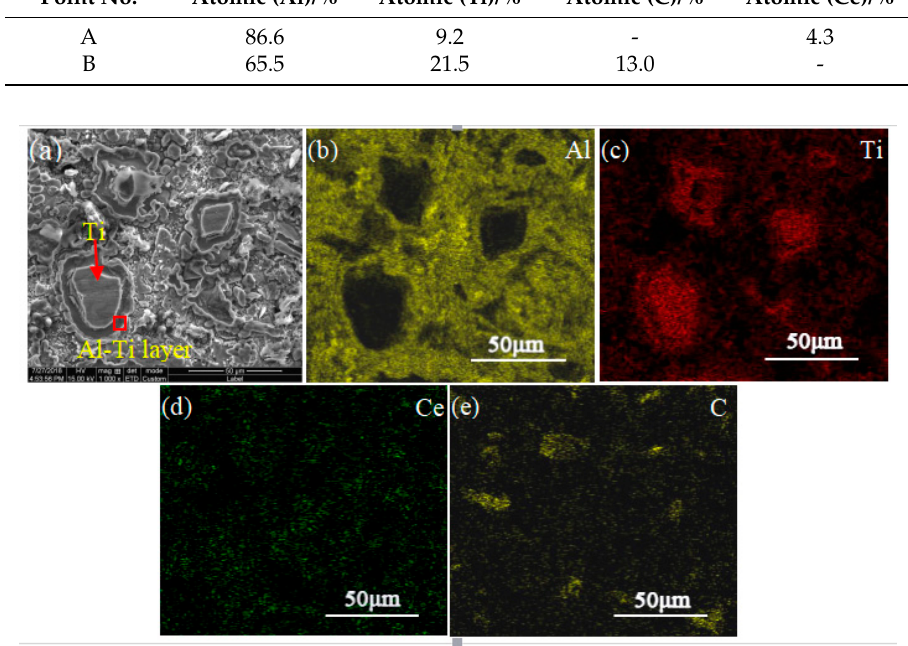
Figure 7. Map scan patterns of Figure 6c: ( a ) Is the SEM image of Figure 6c, ( b – e ) are map scan patterns of Al, Ti, Ce, and C, respectively.